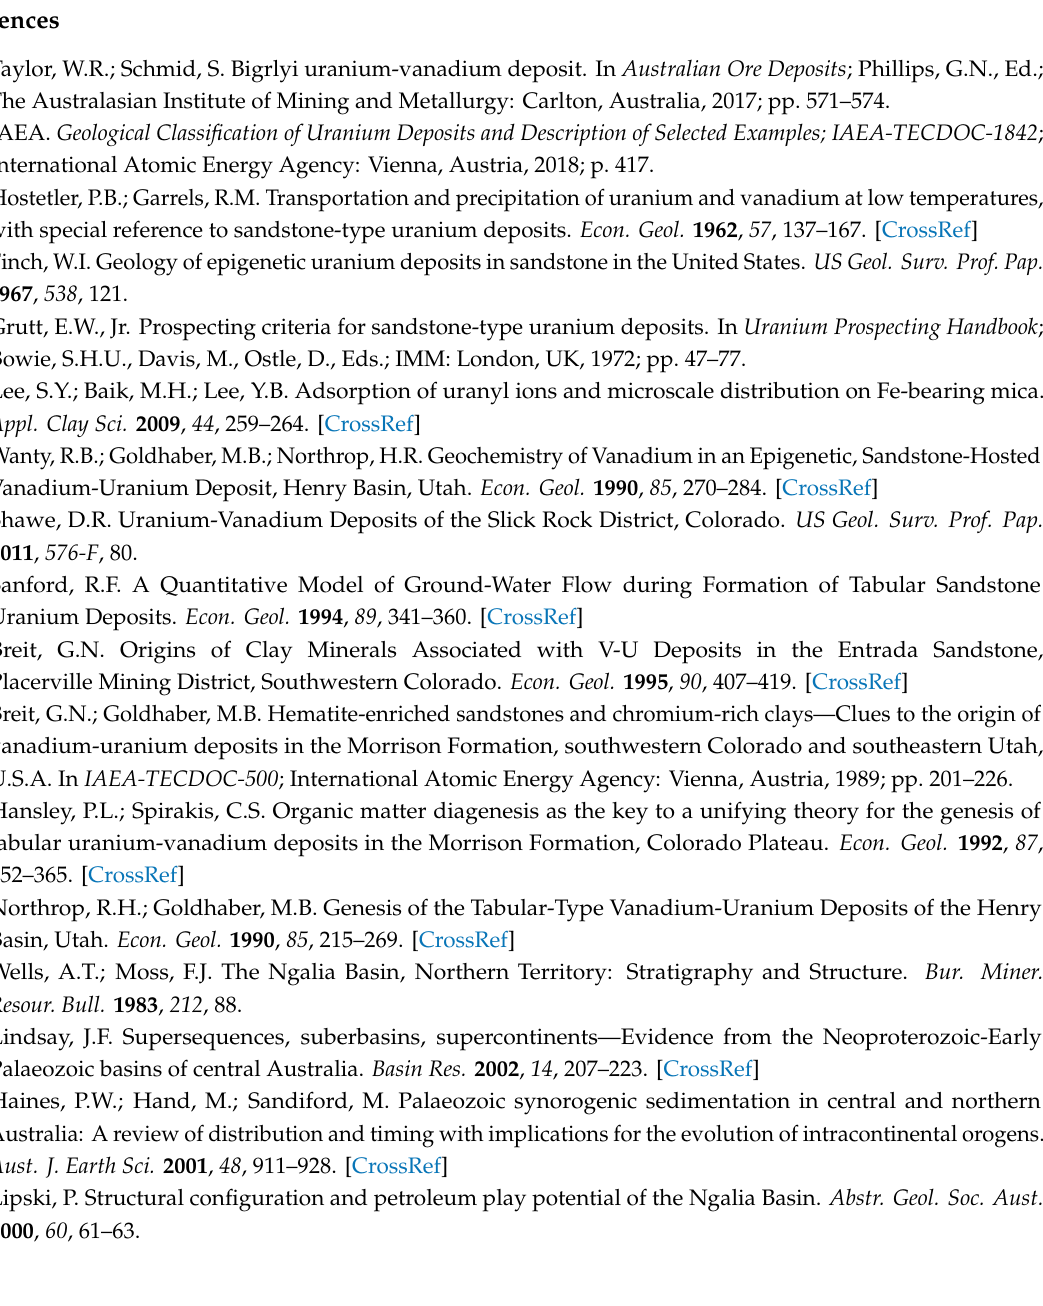
Figure S1: XRD, Table S1: Bigrlyi whole-rock major and trace element geochemistry. Table S2: Bigrlyi Pb Isotope